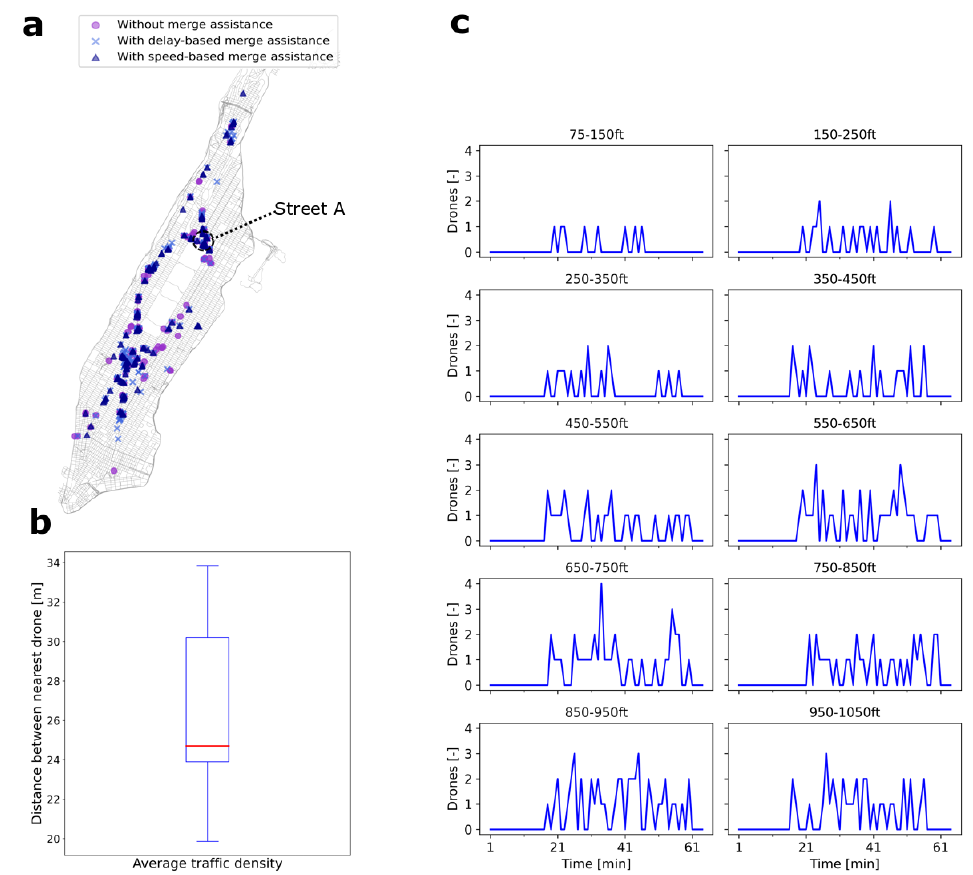
Figure 10. The urban network of Manhattan. ( a ) We overlaid the pairwise intrusions associated without any merge assistance and with delay-based and speed-based merge assist policies. Colours are used to distinguish the different pairwise intrusion categories. The purple marker represent the pairwise intrusions without any merge assistance; the blue cross represents the pairwise intrusions associated with the delay-based merge assist policy; and, the blue triangle marks the pairwise intrusions caused by the use of the speed-based merge assist policy. The darker regions indicate the presence of pairwise intrusions even with the use of delay-based and speed-based merge policies. The map indicates hotspot street at which intrusions are largely prevalent. We identify the street as ‘street A’, which has a length of 62 m. ( b ) We capture the distance between the nearest drone flying over street A using a box-and-whisker plot. The plot shows that the median is below the horizontal separation margin of 25 m. ( c ) In addition, we capture the traffic accumulation on this particular street. The line plots show that there are instances when there are between two to four drones on the same layer flying over the